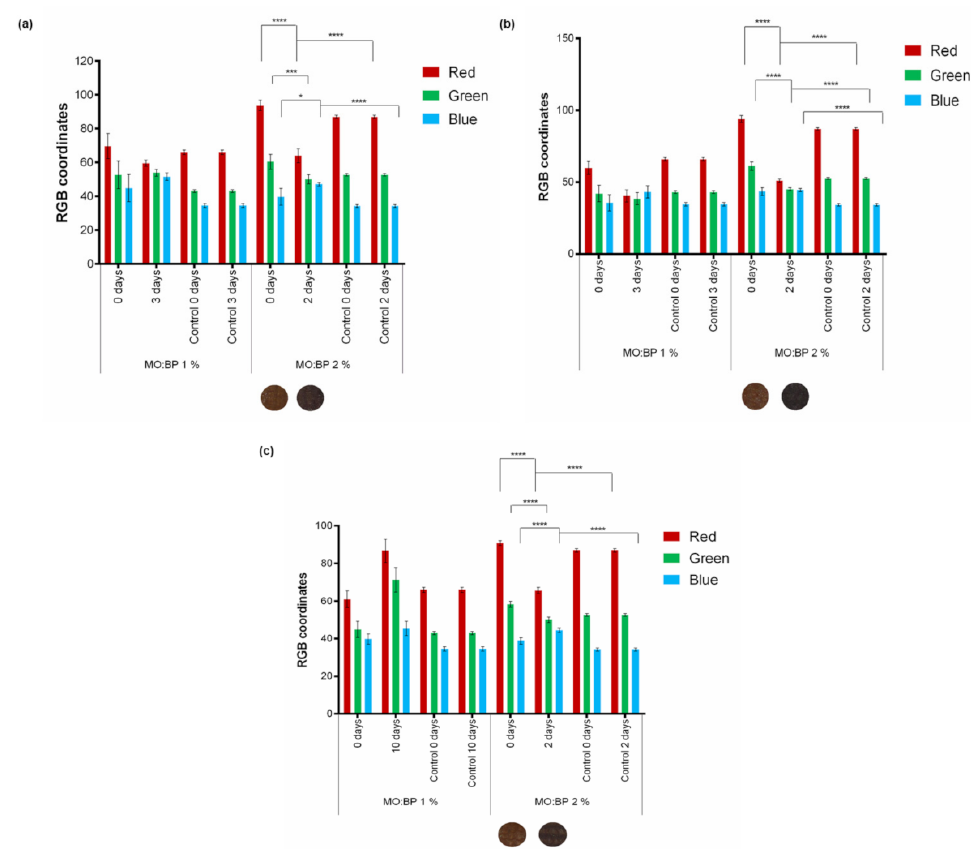
Figure 9. RGB coordinates presented by the MO:BP sensor at concentrations of 1% ( w / v ) and 2% ( w / v ) before and after exposure to an isolated environment within the presence of ( a ) salmon, ( b ) beef steak, and ( c ) strawberry ( n = 3, ± SD), * p < 0.05, *** p < 0.001, **** p < 0.0001 (one-way ANOVA, Š í d á k’s test). The control refers to the sample submitted to a closed environment in the absence of food. The visual color obtained for MO:BP 2% ( w / v ) at 0 and 2 days is also